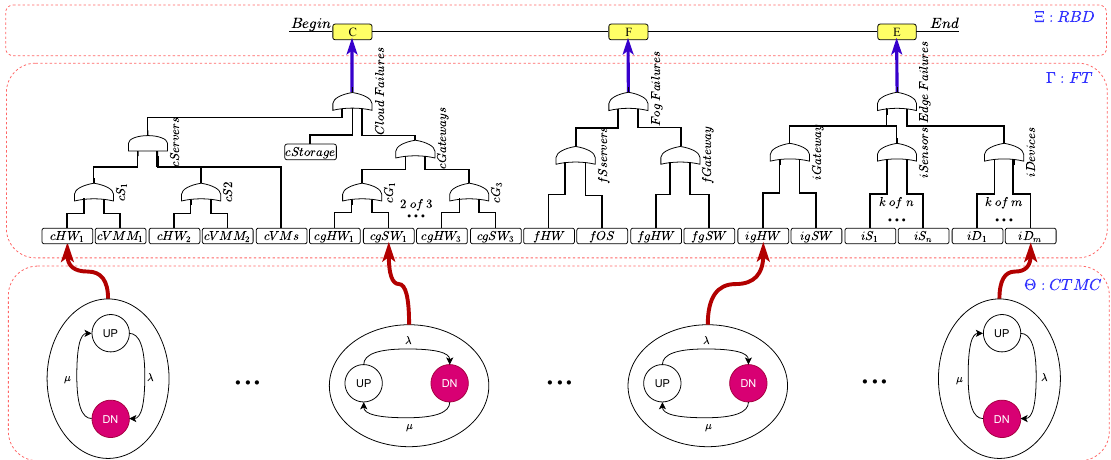
Figure 4. Overall hierarchical model of an IoT smart factory